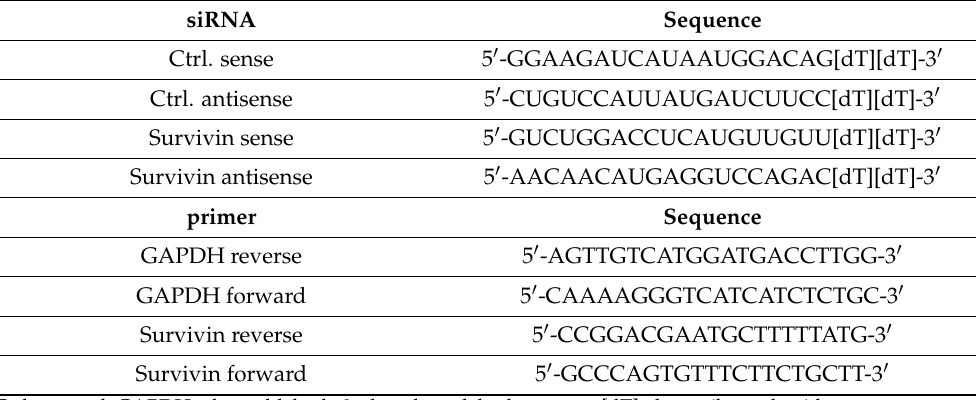
Table 1. Sequences of siRNAs and primers used for